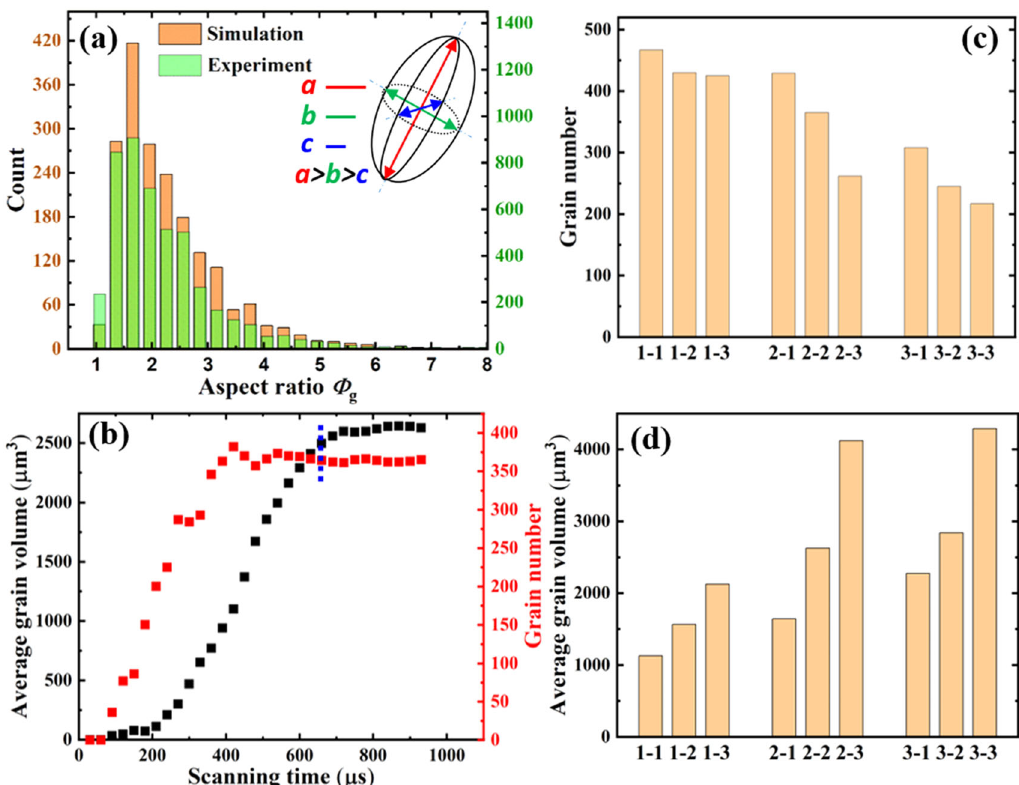
Fig. 6 Evolutions of grain size during the SLM. a Aspect ratios of grains within all the scanning tracks; b evolutions of grain number and average grain volume in the solidi fi ed region during the scanning of the 2 nd layer 2 nd track. The blue dot line in b indicates the time when the scanning track is completely solidi fi ed. c Final grain number and d average grain volume in the solidi fi ed region of each speci fi c track, where the symbols such as 1-1 and 2-3 donate the speci fi c layer and track such as the 1 st layer 1 st track and 2 nd layer 3 rd